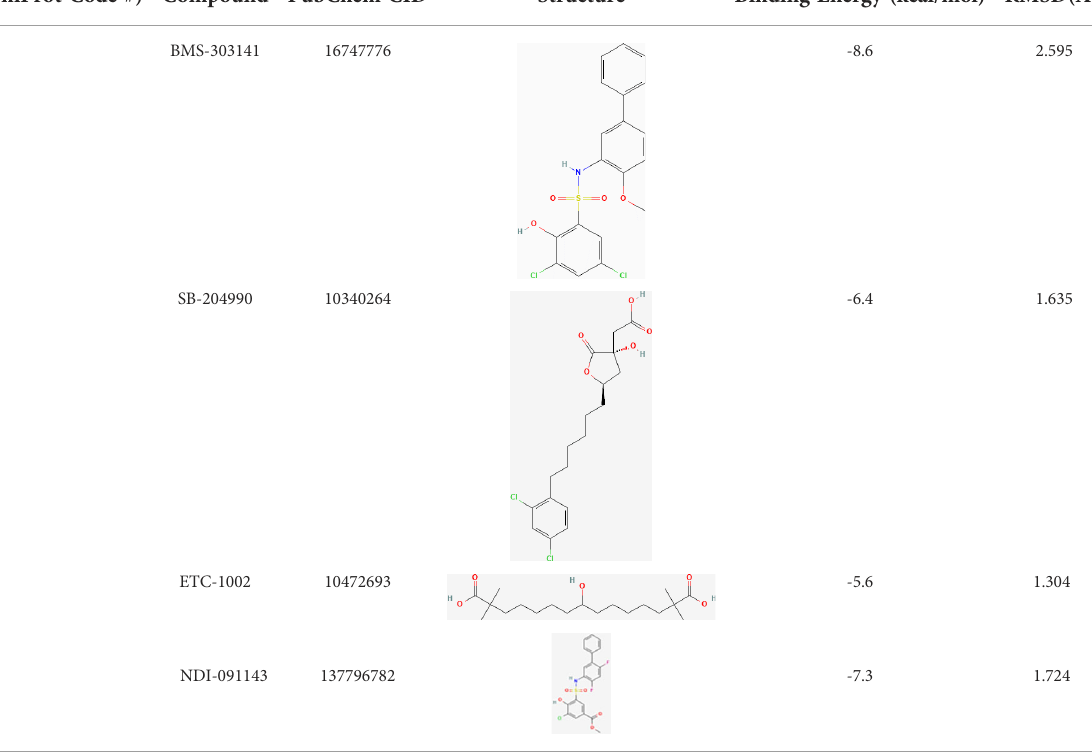
TABLE 2 Results of AutoDock-Vina docking study. Receptor(UniProt Code #) Compound PubChem CID